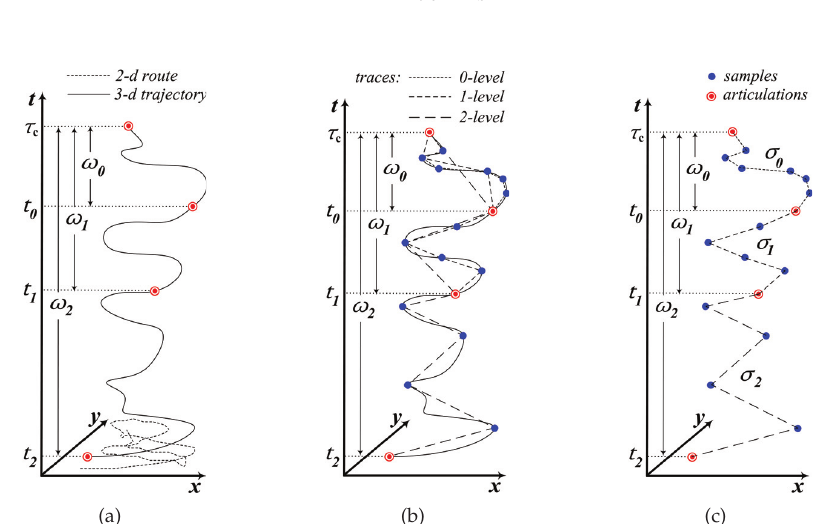
Figure 3: Multi-scale sliding window over trajectory: (a) Original sequence. (b) Traces over diverse time horizons. (c) Unified synopsis composed of non-overlapping